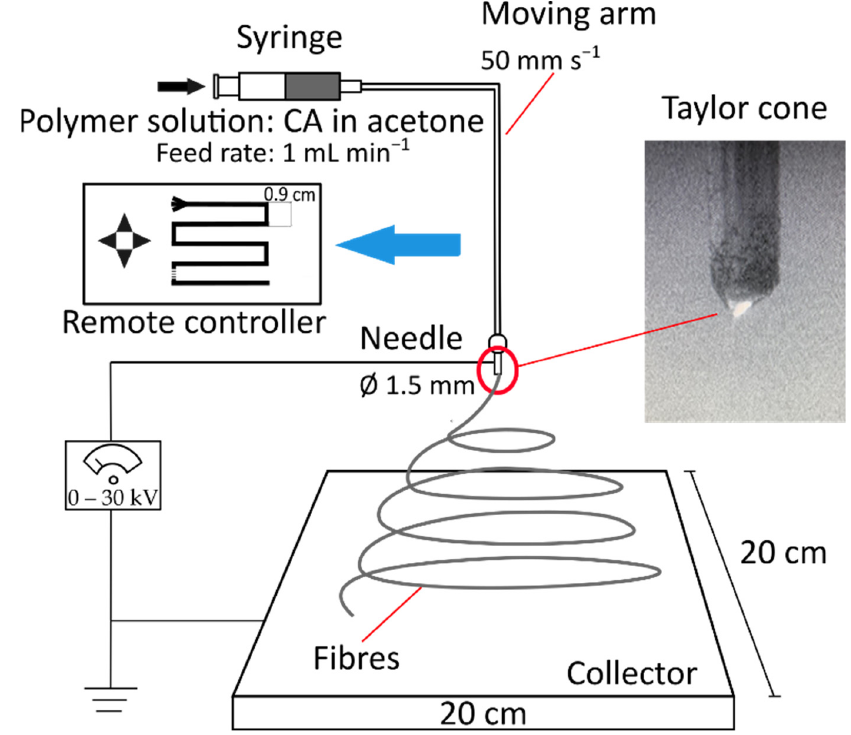
Figure 1. Schematic representation of the electrospinning setup.